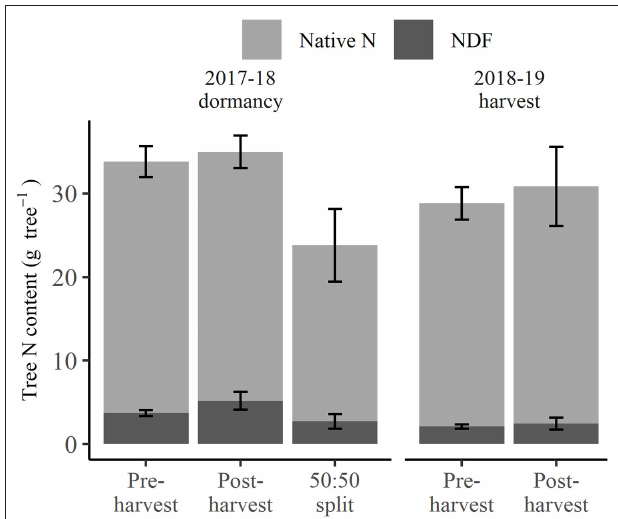
FIGURE 3 | Amount of nitrogen derived from fertilizer (NDF) and unlabeled N (Native N) of perennial storage organs excluding fruit and leaf for N-treated trees destructively harvested at the 2018 dormancy and the 2019 harvest under different N fertigation treatments. Error bars represent ± SEM, n = 4.